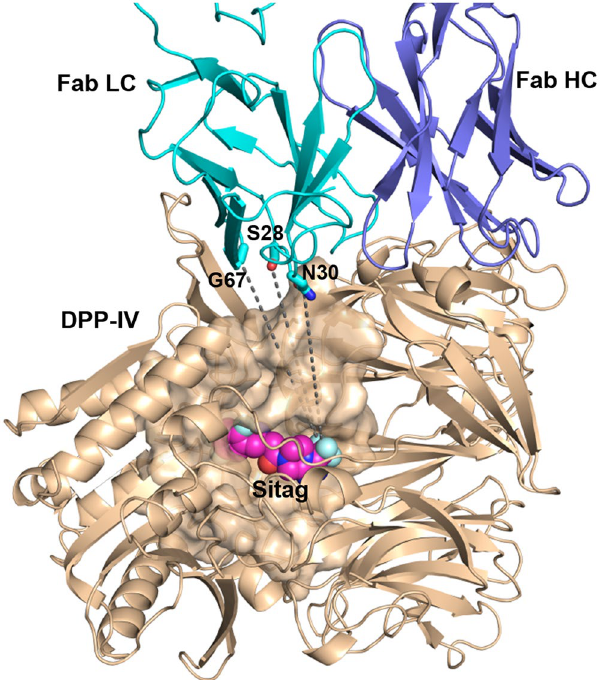
Figure 1. Co-crystal structure of the ternary complex of DPP-IV (wheat ribbons and surface) bound with 11A19 Fab (teal and blue ribbons) and small molecule (SM) 1 (spheres). PDB code: 4FFW. Three residues on the Fab identified as potential conjugation sites are labeled and shown in stick.